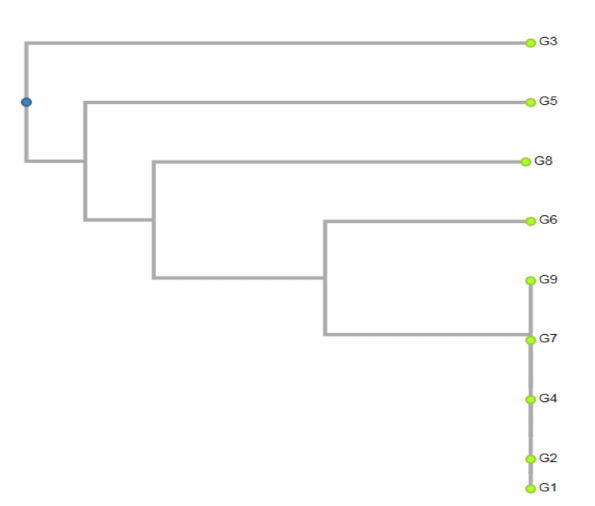
Figure 3. Dendrogram constructed by using the unweighted pair group method using arithmetic averages (UPGMA) cluster analysis of 9 genotypes of Ginkgo biloba on miRNA markers gb-miR160_F & gb-miR75_R. G1—Nov á Ves nad Žitavou, G2—Topol’ˇcianky, G3—Luˇcenec, G4—Vel’k ý Blh,